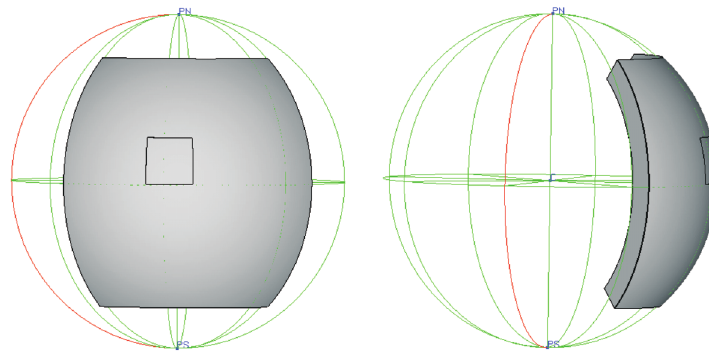
Fig. 21. Pictorial view of the spherical domain built up to investigate the 2004 Sumatra